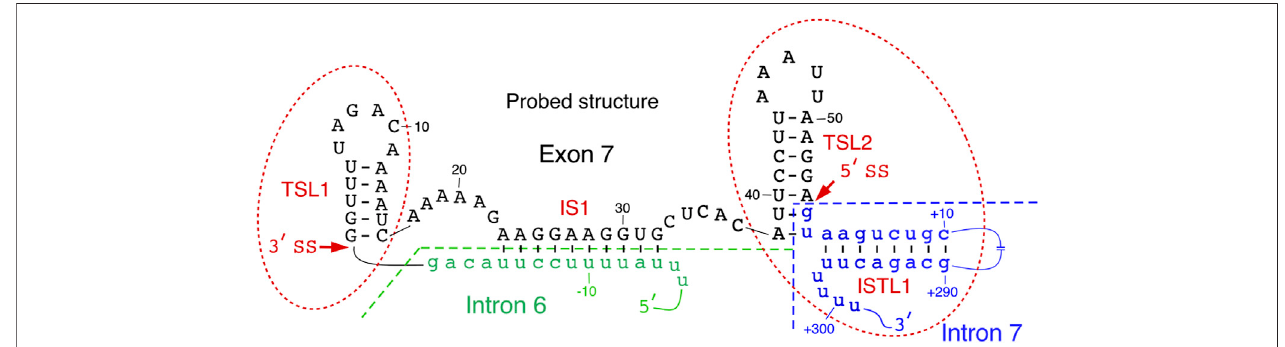
FIGURE 2 | Local structure of SMN exon 7 and adjacent upstream/downstream intronic sequences. Existence of TSL2 and its effect on exon 7 splicing was also con fi rmedbymutationalanalysis.Intron6andintron7sequencesareshowninsmall-casegreenandblueletters,respectively.Exon7sequenceisshowninupper-case black letters. Numbering of nucleotides, neutral, positive and negative, starts from the fi rst position in exon 7, fi rst position of intron 7 and the last position in intron 6, respectively. Thesplice sitesofexon7areindicatedbythearrows. IS1structure isboxed. Abbreviation:IL,internal loop;IS,internal stem;TSL,terminalstemloop.